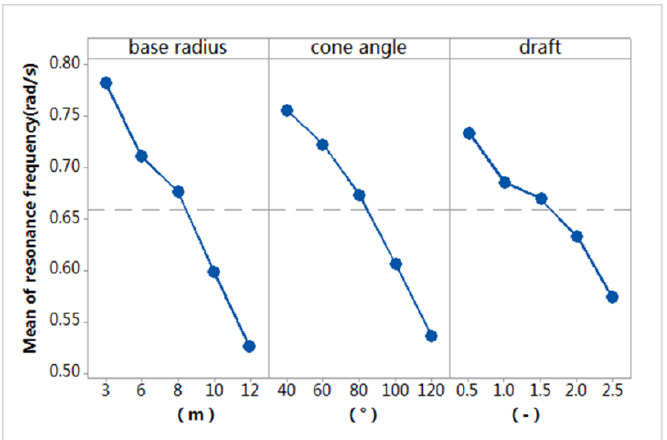
Figure 7. Main effects diagram for resonance frequency. Energies 2018 , 11 , 2645 Figure 8. Main effects diagram for absorption bandwidth.